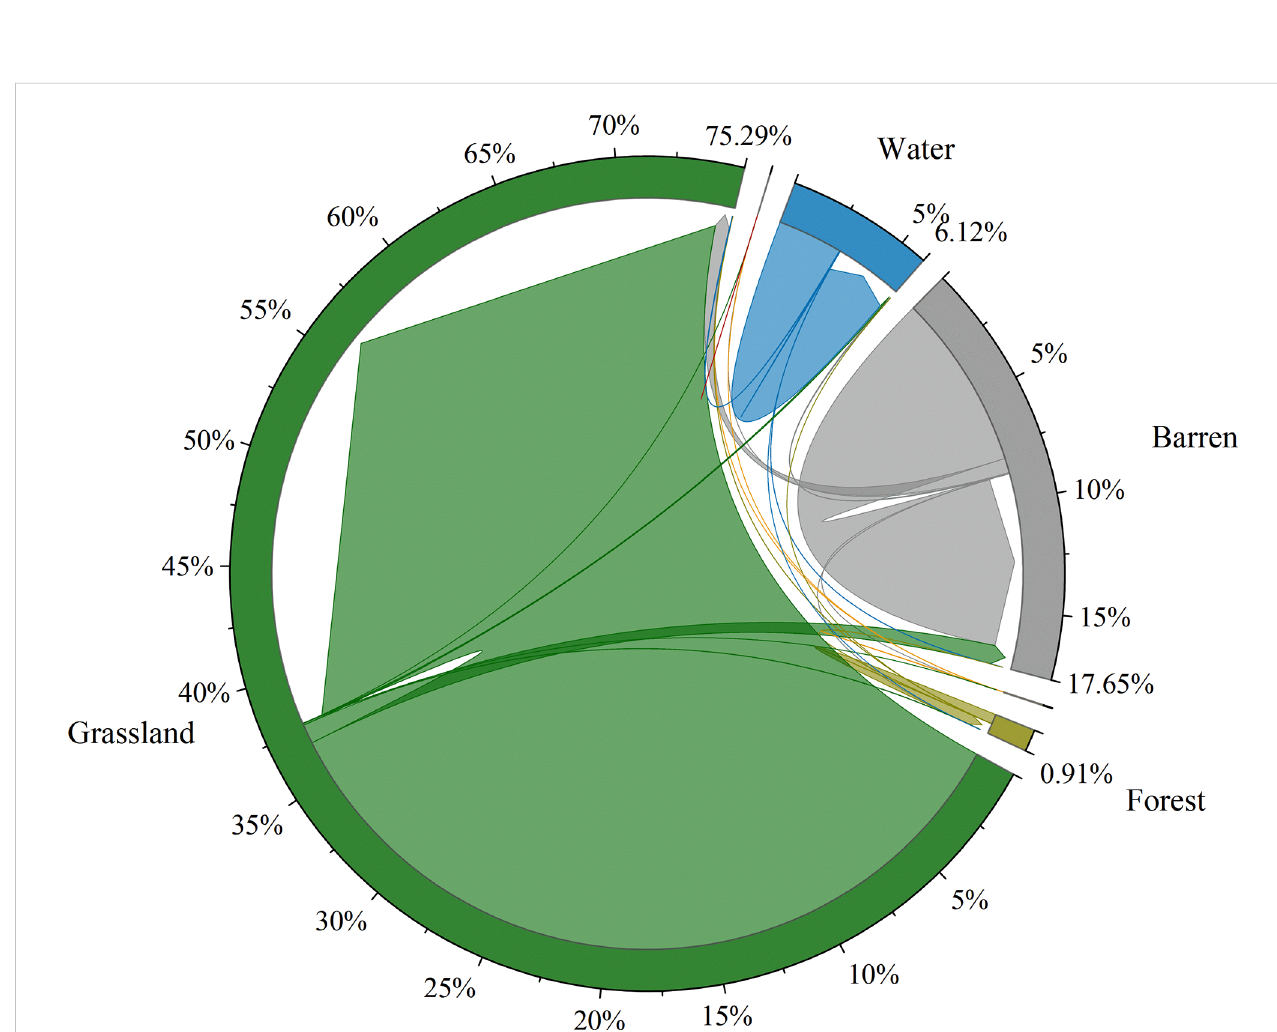
FIGURE 6 The land use transformation from 1990 to 2015.